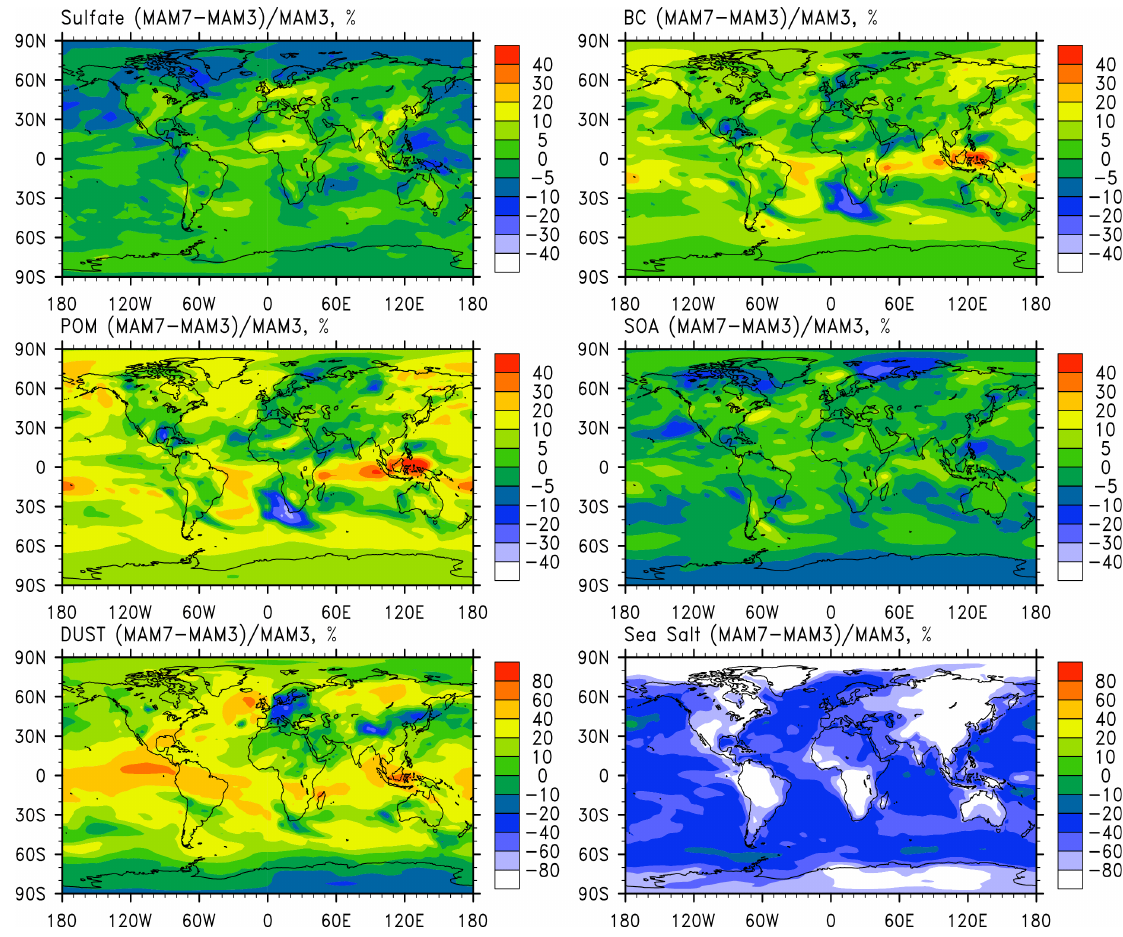
Fig. 3b. Relative differences (in %) of annual mean vertically integrated concentrations of sulfate, BC, POM, SOA, dust, and sea salt between MAM7 and MAM3.